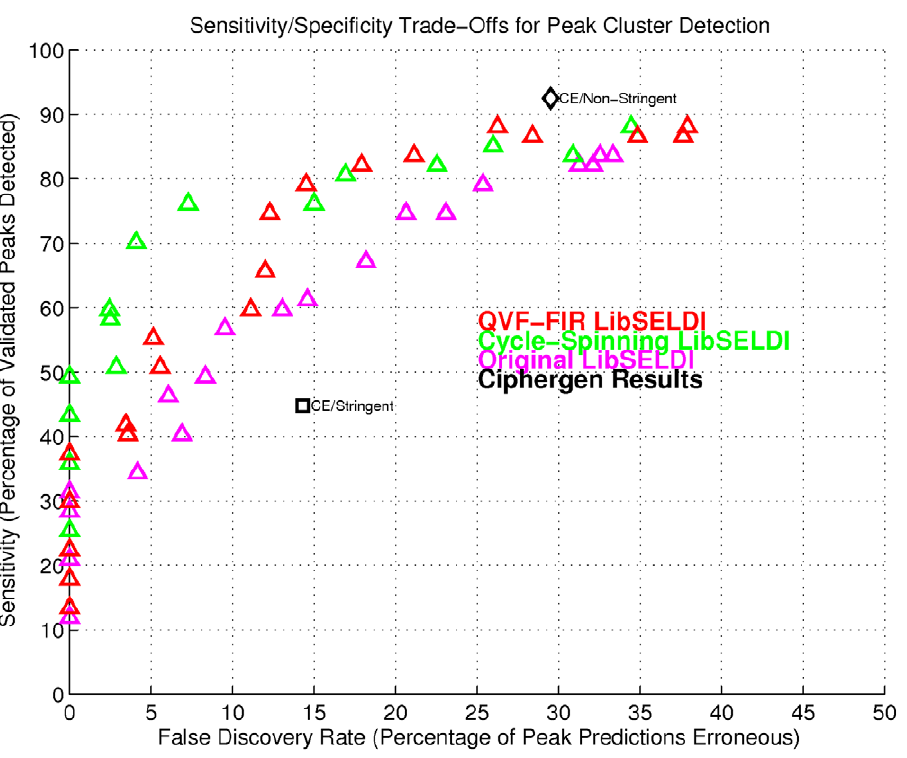
Figure 4. False-discovery rate and true-positive rate operating points showing various stages of improvement for LibSELDI.